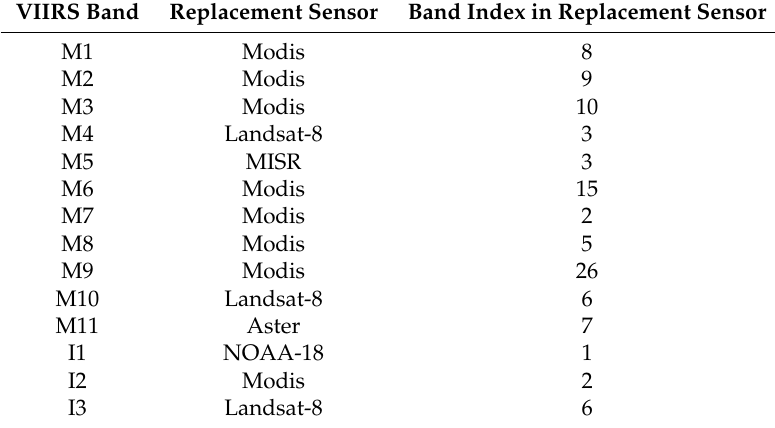
Table 1. Bands of replacement sensors used for Suomi NPP/VIIRS bands in SMAC program.